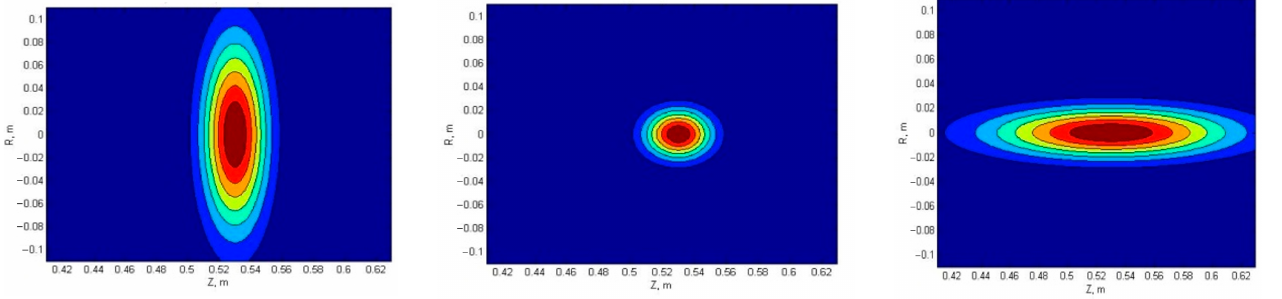
Figure 23. Filament density distribution: ( left ) radially stretched, ( middle ) circular, and ( right ) poloidally stretched filament.